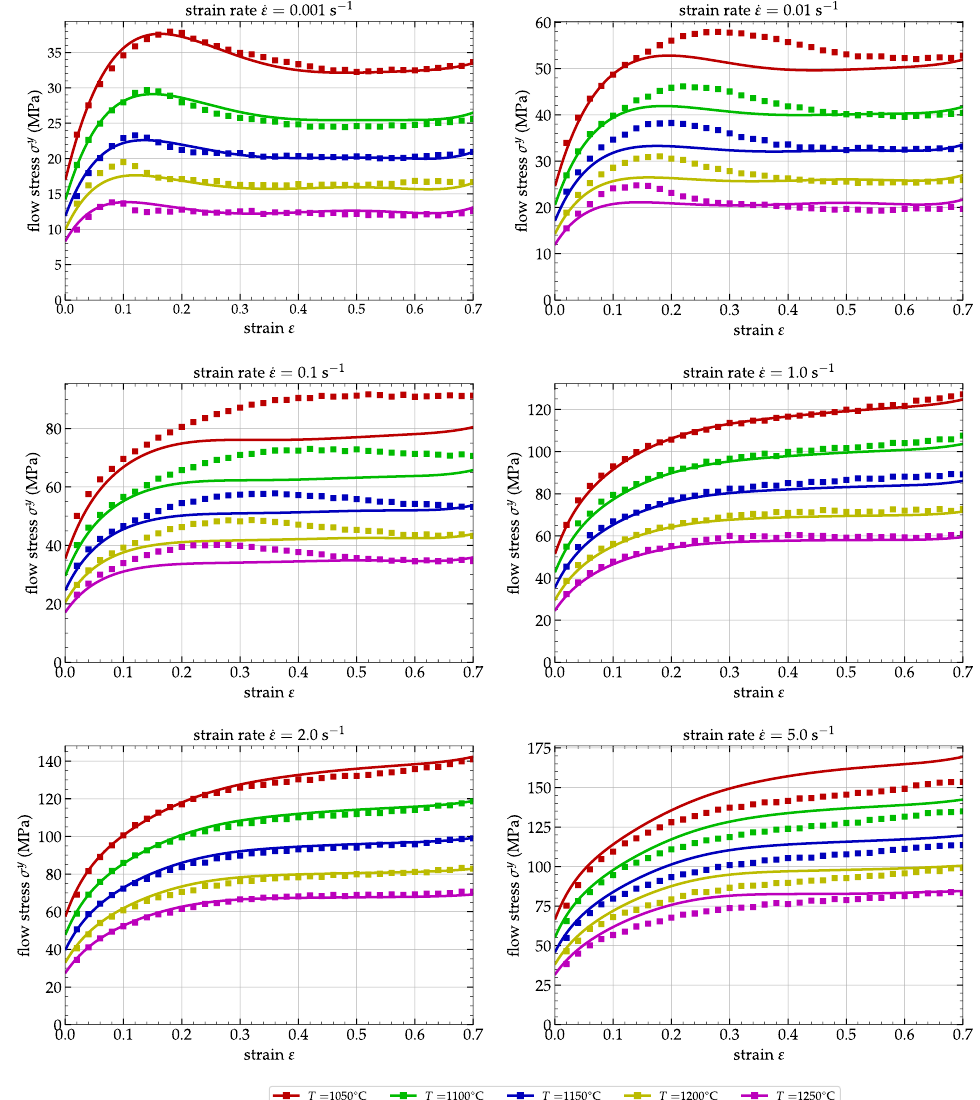
Figure 10. Comparison between the experimental (dots) and predicted (lines) flow stresses σ y by the PTM